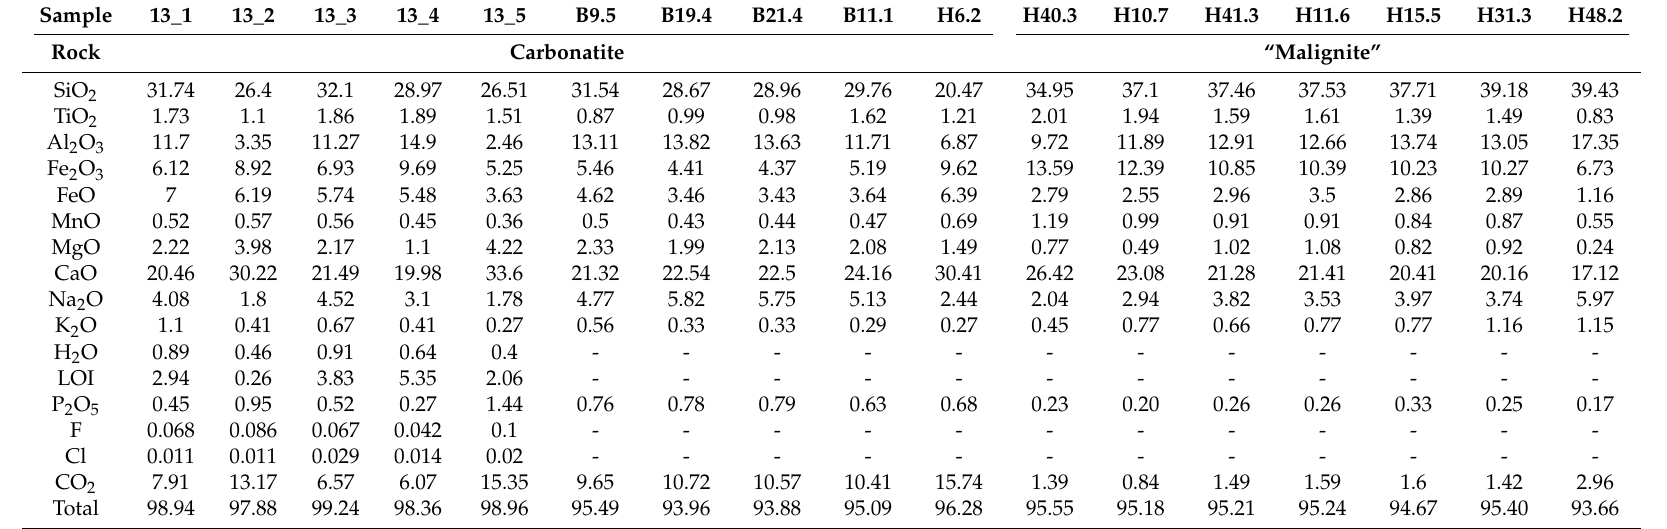
Table 5. Representative major and minor element analyses of the Breivikbotn carbonatite and alkaline rocks (wt